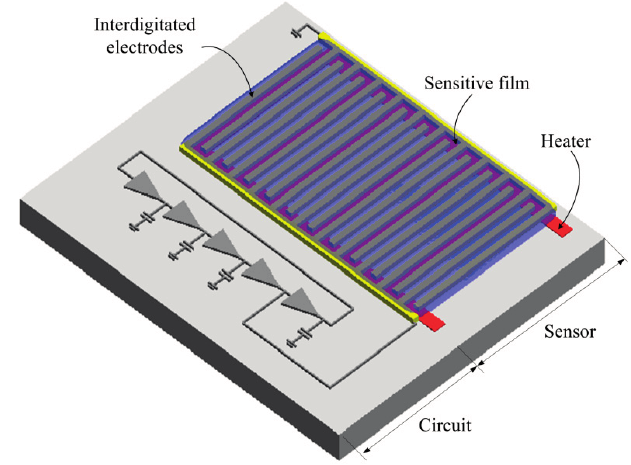
Figure 1. Structure of the integrated ethanol sensor.